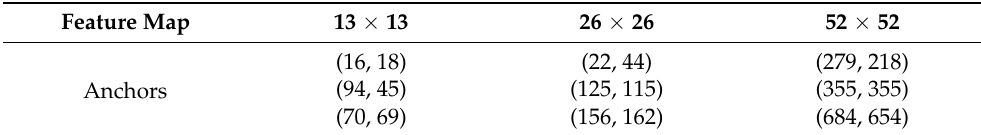
Table 1. Optimized anchors of the different feature